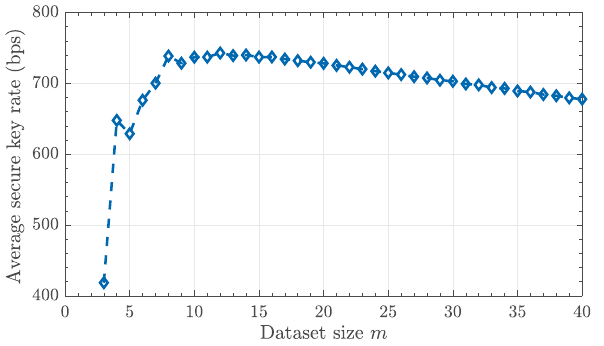
Fig. 3 The average secure key rate with different m . m ranges from 3 to 40 and ρ ′ is optimized.